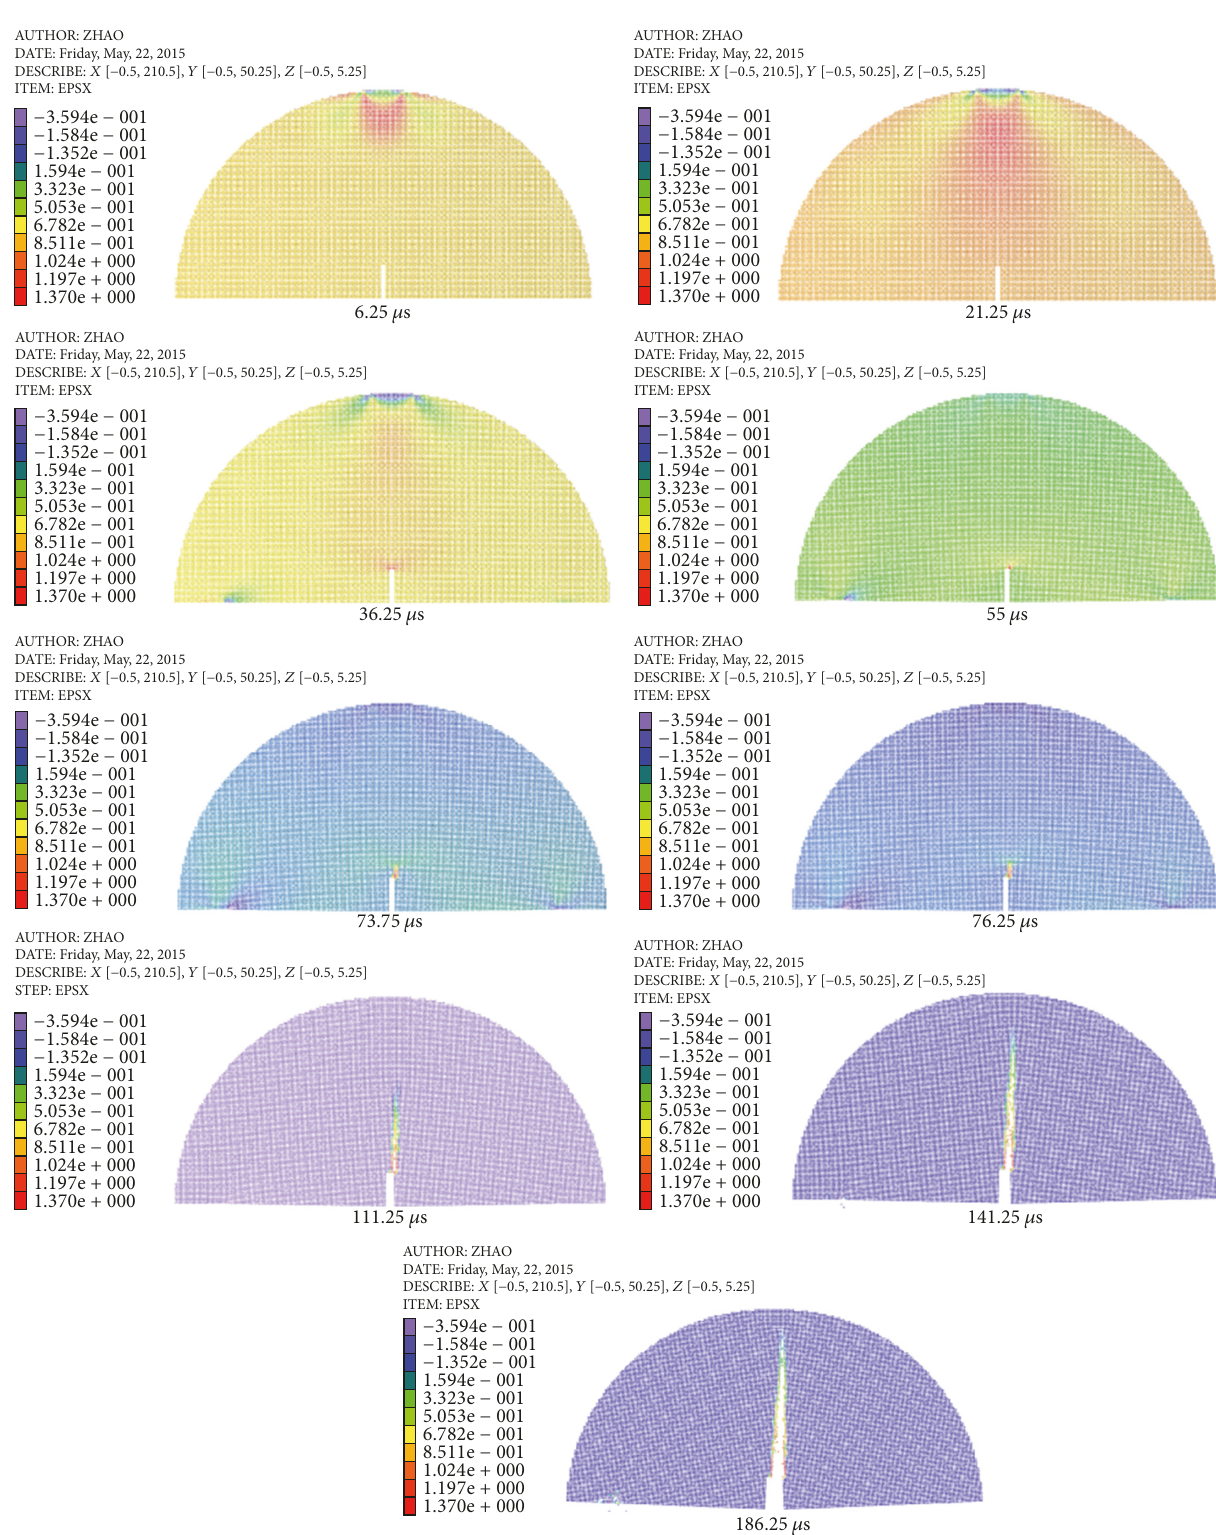
Figure 10: Simulation of the rock specimen fracture